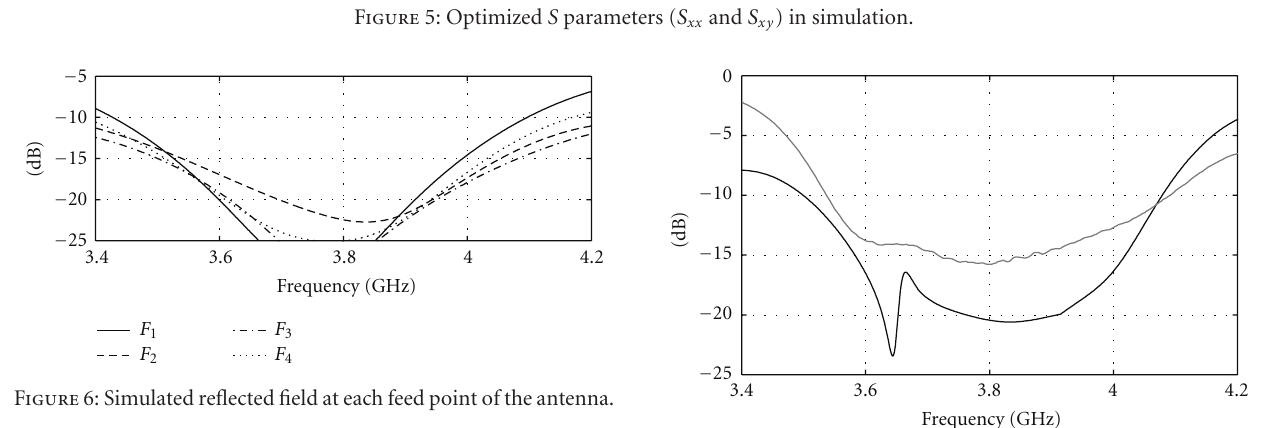
Figure 5: Optimized S parameters ( S xx and S xy ) in simulation.